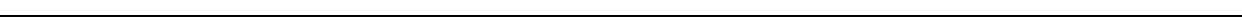
Fig. 5 Mammalian display saturation mutagenesis to identify substitutions that improve or reduce binding. a TB1G1:TEAD binding in surface display tested over a dilution series of biotinylated, 6xHis-tagged TEAD + stain (200 nM → 64 pM), and with different staining methods conferring different avidities. Top row: 1-step co-incubation of TEAD and streptavidin for tetravalent staining (4x). Middle row: 1-step co-incubation of TEAD and anti-His antibody for bivalent staining (2x). Bottom row: 2-step incubation, fi rst with TEAD followed by pelleting and resuspending in solution with streptavidin, for monovalent staining (1x). Signal:noise ratios, quantitated by Alexa Fluor 647 levels in transfected (signal, S) vs. untransfected (noise, N) cells using fl ow cytometry,